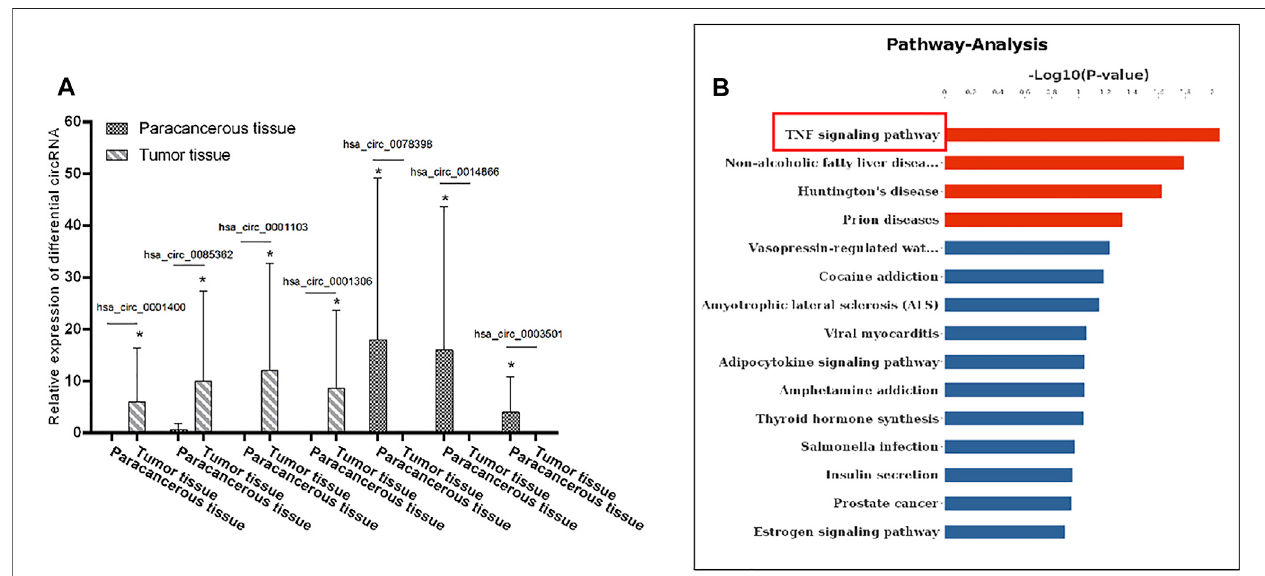
FIGURE 1 | Differential expression levels of circRNA in cervical cancer: (A) The expression levels of hsa_circRNA_0001400, hsa_circRNA_0085362, hsa_circRNA_0001103, and hsa_circRNA_0001306 were signi fi cantly increased and those of hsa_circRNA_0078398, hsa_circRNA_0014866, and hsa_circRNA_0003501 were signi fi cantly decreased. B) KEGG was used to analyze the signal pathway involved in the differential expression of circRNA. Data are expressed as mean ± standard deviation, n (cid:2) 3, * p < 0.05 and ** p < 0.01 vs. control